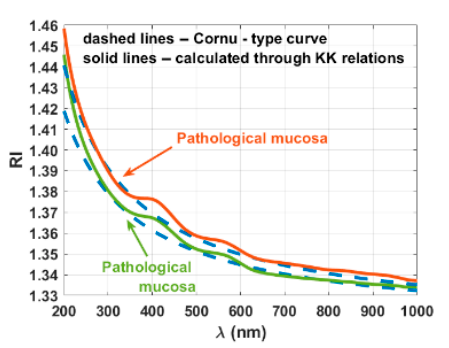
Figure 8. Tissue dispersion calculated through K-K relations and by Cornu-fitting of experimental data for the normal and pathological mucosa.